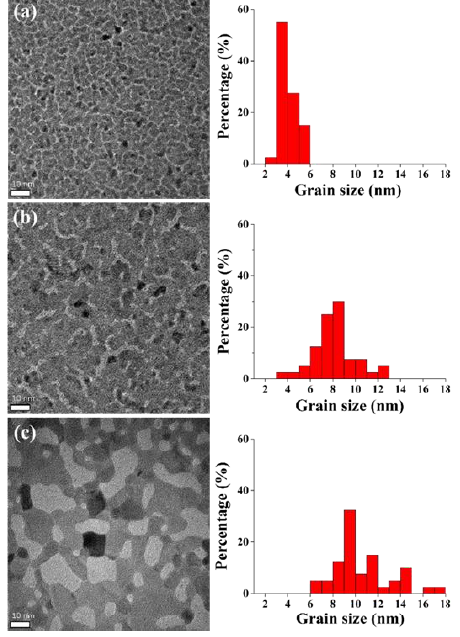
Figure 6. TEM top-view images and the average grain sizes of the Ru films for 40 grains: ( a ) as deposited, ( b ) after annealing at 300 °C, and ( c ) after annealing at 500 °C.